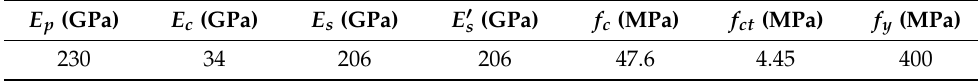
Table 2. Parameters of RC beam strengthened by CFRP.